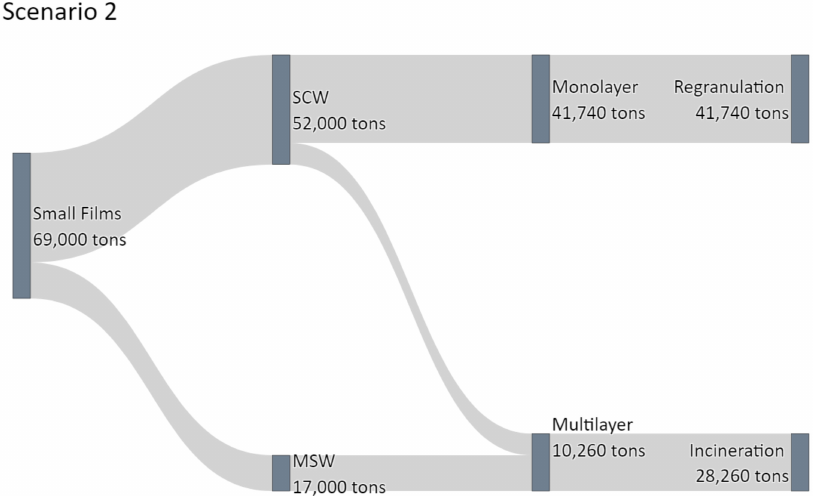
Figure 9. Sankey diagram depicting the waste flow in Scenario 2 with increased mechanical recycling of monolayer